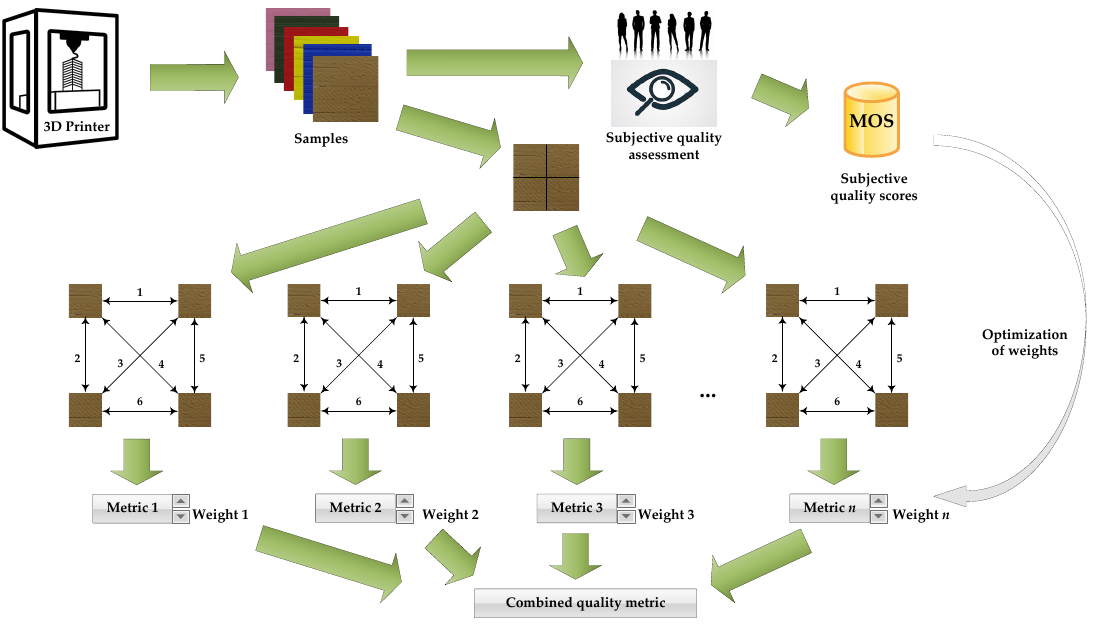
Figure 3. Illustration of the experimental